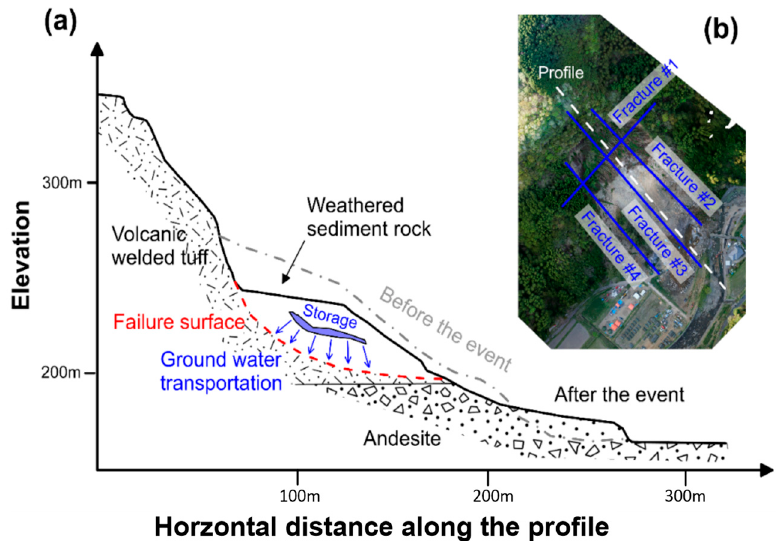
Figure 9. Speculation of the triggering mechanism of the 2018 Yabakei landslide event. ( a ) Profile of the landslide. ( b ). Major fractures in the landslide